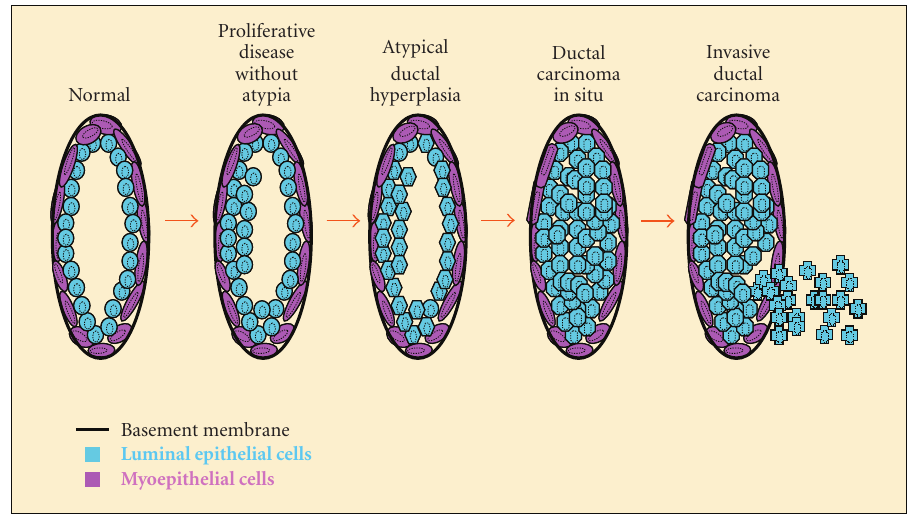
Figure 1: Hypothetical model of breast tumorigenesis and progression. The stepwise progression of breast cancer is described as a continuum of lesions from epithelial hyperplasia to invasive carcinoma and eventually metastasis.